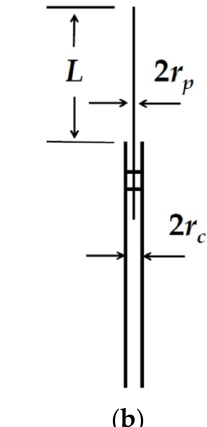
Figure 1. Experimental device and measurement setup. Reproduced with permission from Díaz Cabrera et al., Measurement; Reprinted with permission from ref. [14]. Copyright 2014 Elsevier.